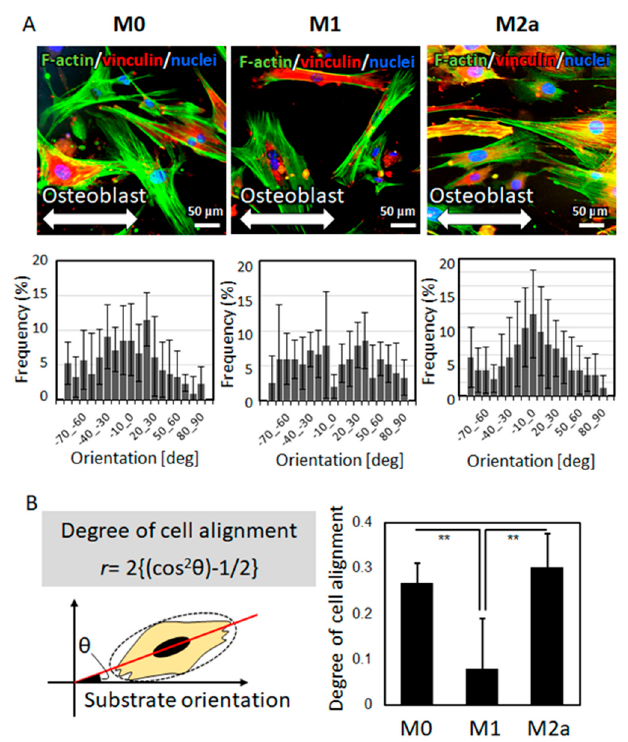
Figure 4. ( A ) Osteoblast alignment, along the orientation of the collagen substrates (indicated by bidirectional arrows), under co-culture with polarized macrophages is shown. The angular cell distribution is shown below the corresponding images. ( B ) Degree of osteoblast alignment was analyzed against the collagen substrate orientation. The comparison of osteoblast alignment with different types of polarized macrophages is shown; ** p < 0.01.